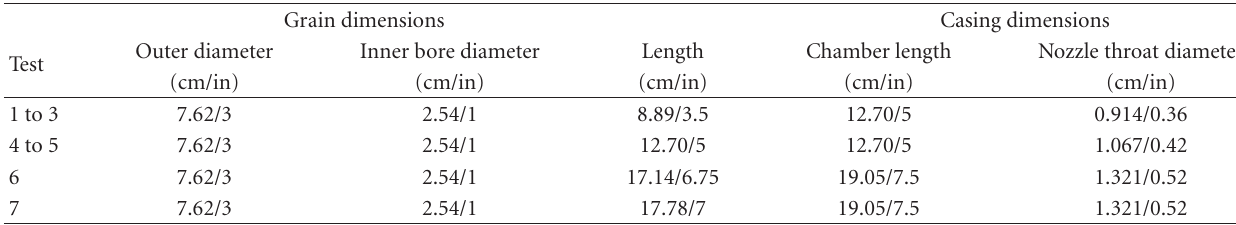
Table 2: ALICE grain